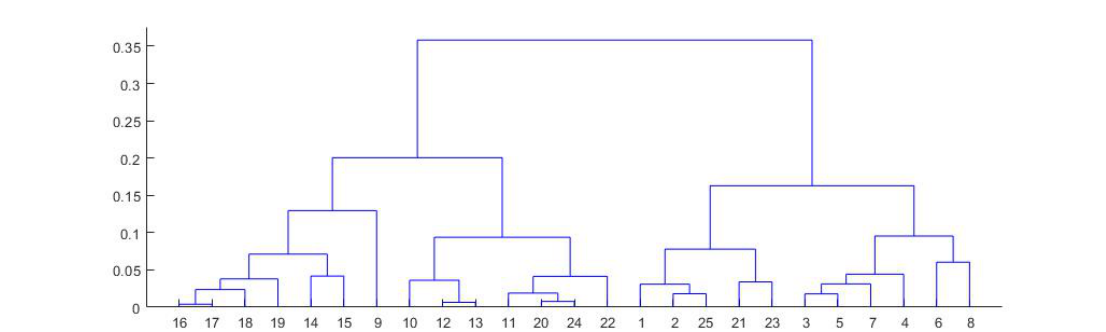
Figure 9. The dendrogram of hierarchical clustering.